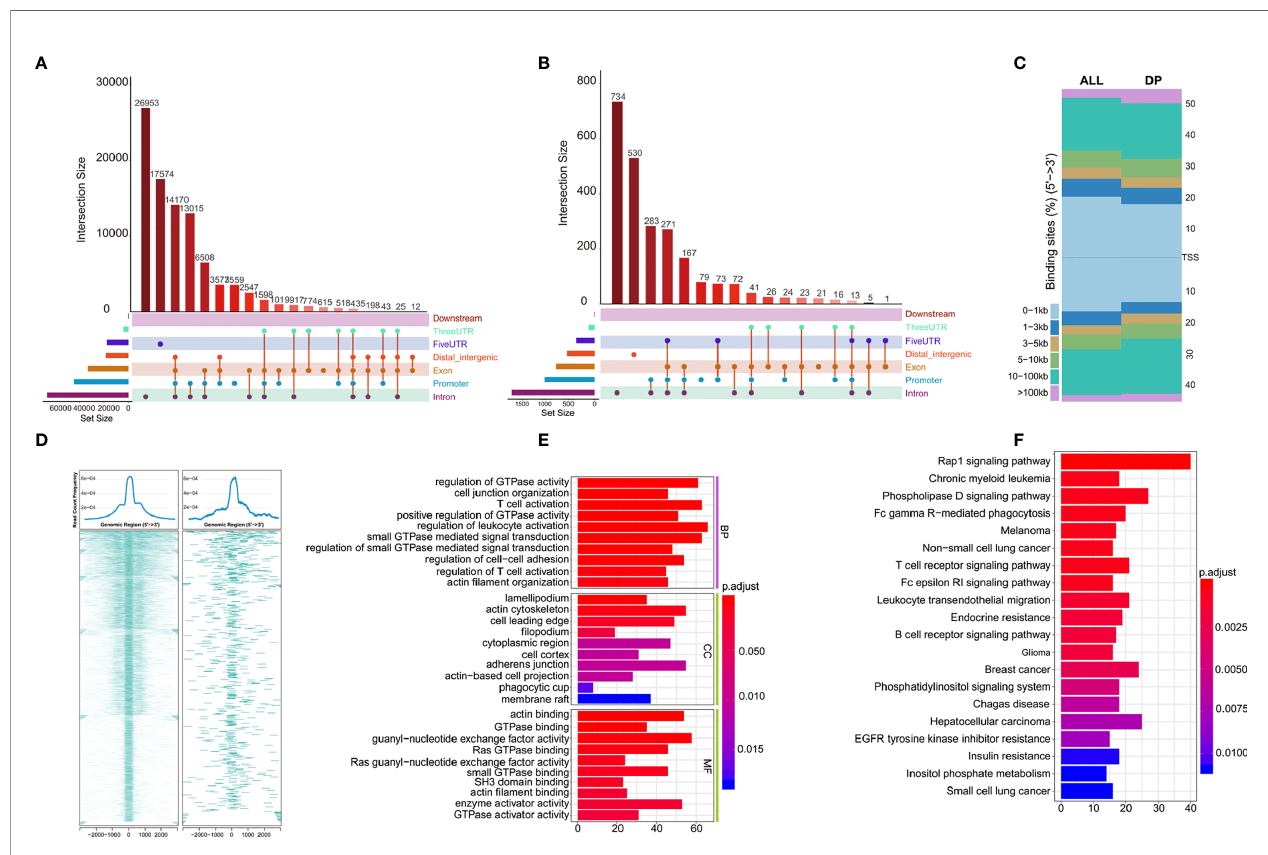
FIGURE 5 | Annotations of Differential peaks. (A) UPSET graph shows the distribution of all peaks. No peak distribution is seen downstream, most peaks are distributed in the introns, one peak can be distributed in multiple regions at the same time (such as introns, promoter, exon, 3 ’ -UTR), peak proportion of containing both exon and promoter is the highest. (B) UPSET shows the distribution of differential peaks. A higher proportion of peaks simultaneously across the 5 ’ UTR, but the total 5 ’ UTR area ratio decreases; (C) Distribution of all (ALL) and differential peaks (DP) at the transcription start site. It shows that the proportion of peaks upstream of the 5 ’ transcription start site decreases; (D) Visualization of peaks on both sides of the TSS site in the range of 0.1 – 1 kb, which shows differential peaks becomes smaller; (E, F) GO and KEGG enrichment of differential peaks ( Supplementary Table 7